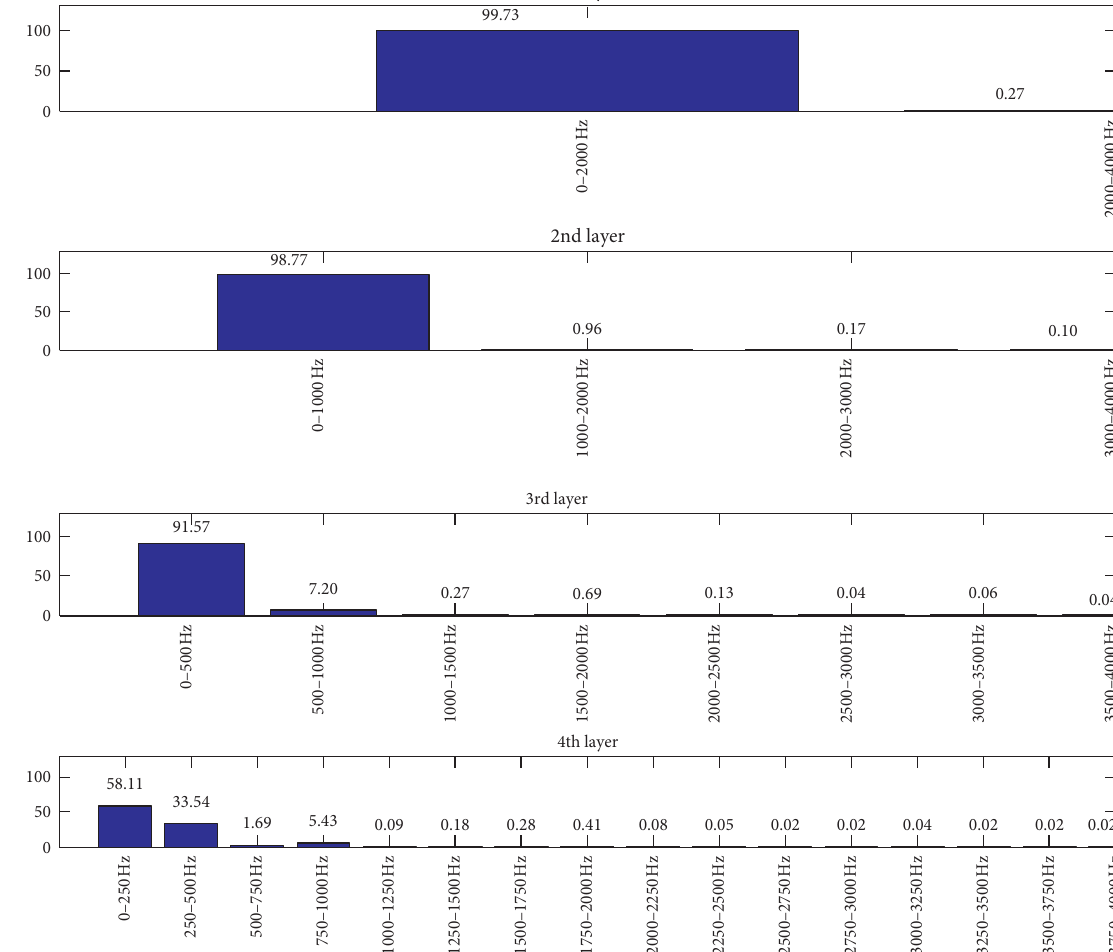
Figure 5: Energy distribution of the usual charge by wavelet packet